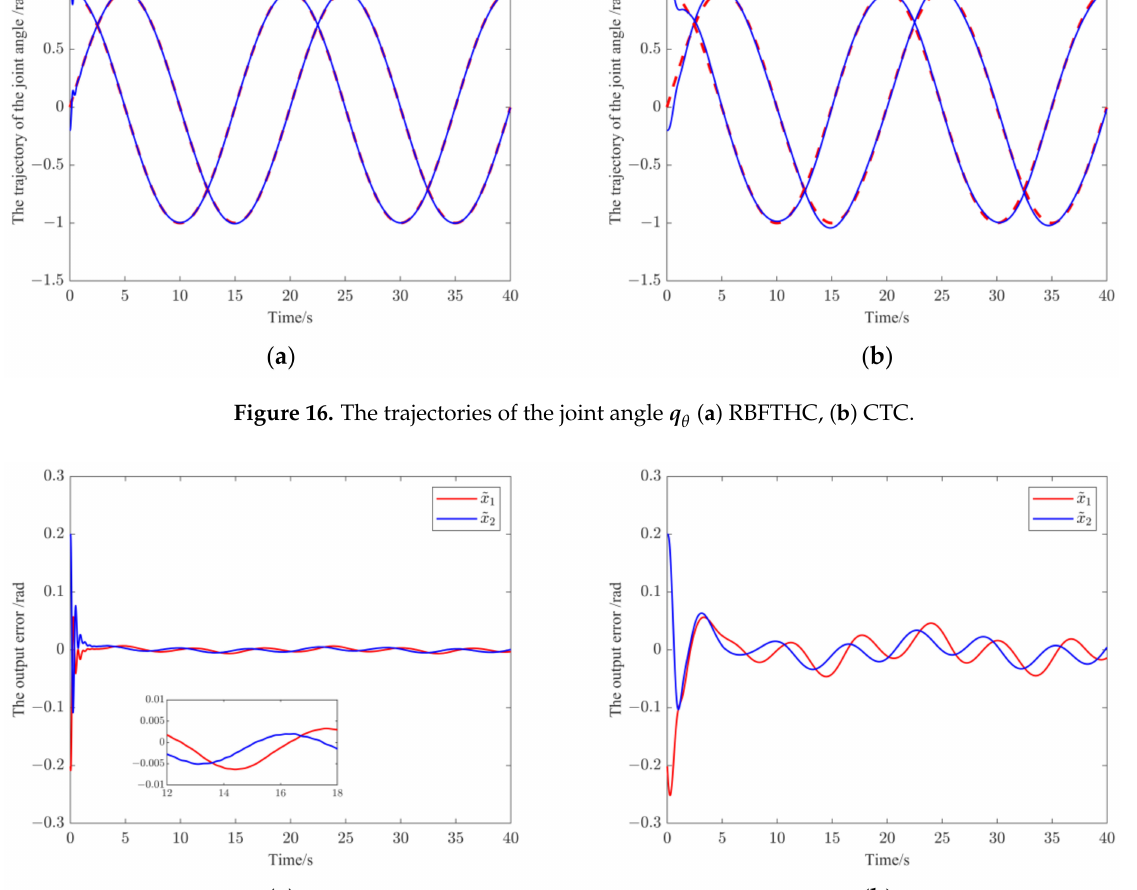
Figure 17. The output error (cid:101) x . ( a ) RBFTHC, ( b ) CTC.